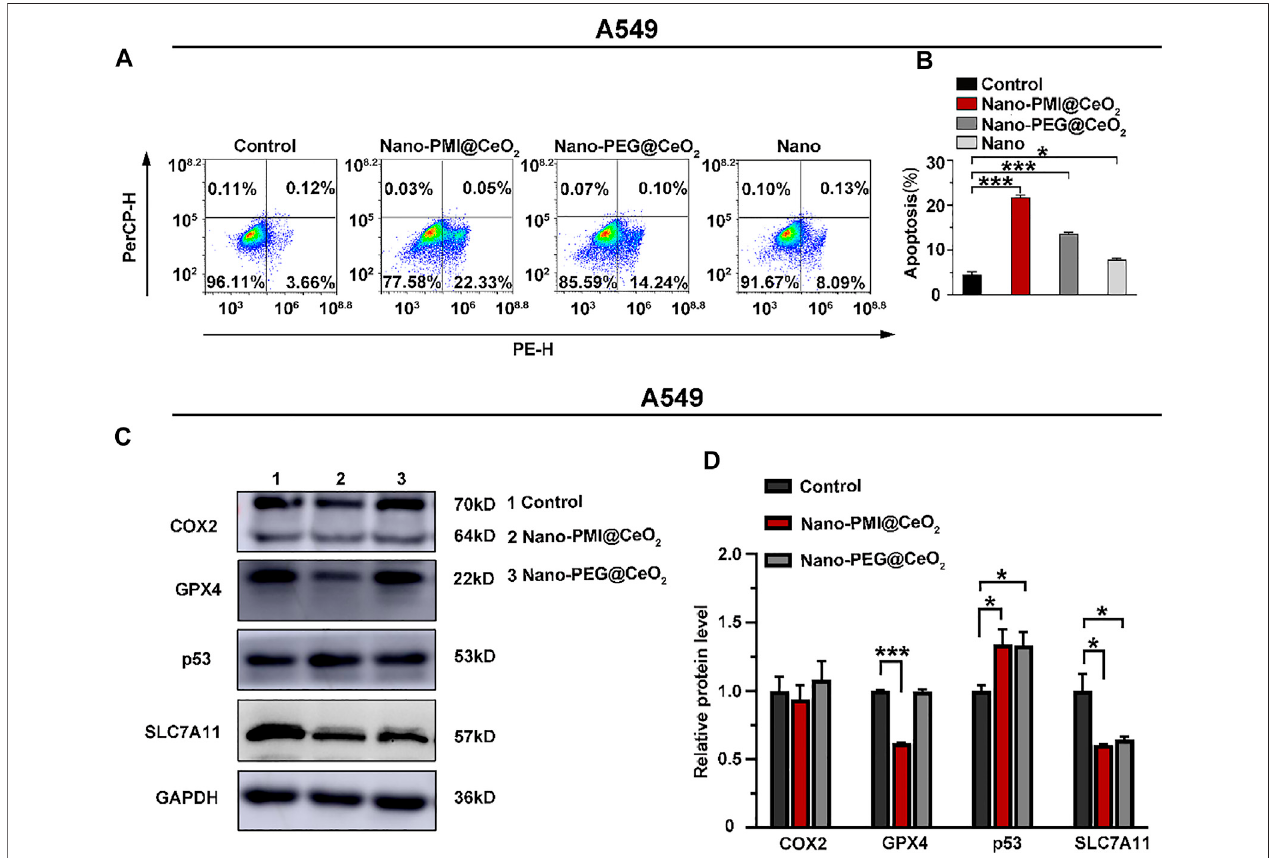
FIGURE 3 | Nano-PMI@CeO 2 potently enhanced tumor apoptosis in vitro by targeting p53 pathways and inducing ferroptosis. (A) Apoptosis effects of these NPs on the A549 cell line measured by fl ow cytometric analysis. (B) Apoptosis rate was showed as mean ± SE ( n = 3). p values were calculated by t -test (*, p < 0.05; **, p < 0.01; ***, p < 0.001). (C) Protein expression was shown of COX2, GPX4, p53, and SLC7A11 in A549 cell line treatment with 0.02 mg/ml Nano-PMI@CeO 2 , 0.02 mg/ml Nano-PEG@CeO 2 using Western blot. (D) Relative protein levels of COX2, GPX4, p53, and SLC7A11 were calculated using ImageJ. Experiment results were presented as mean ± SE ( n = 3) p values were calculated by t -test (*, p < 0.05; **, p < 0.01; ***, p <